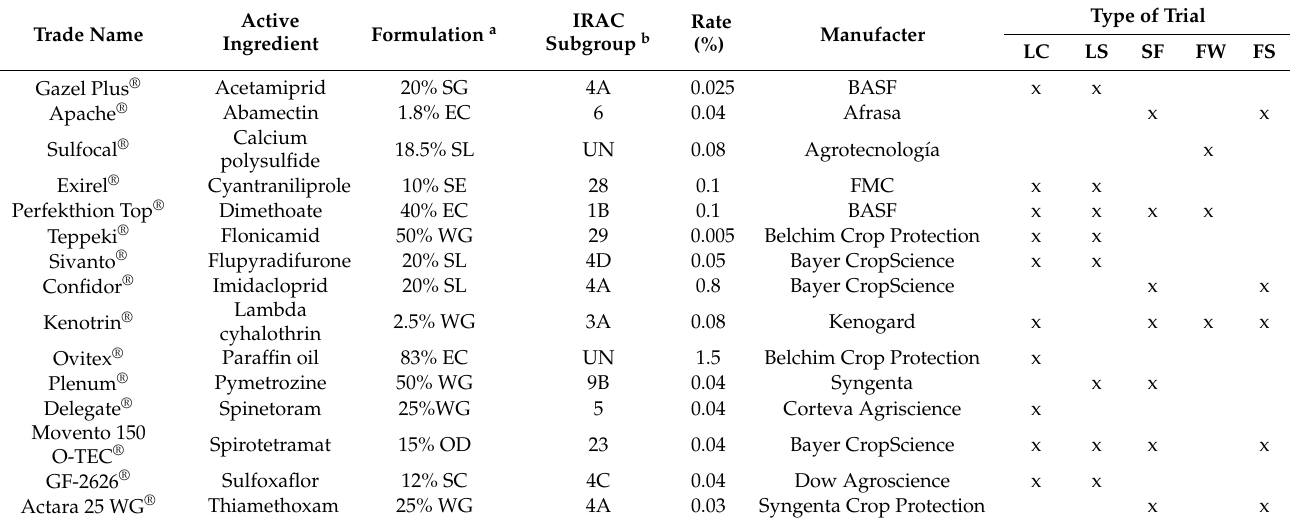
Table 1. Insecticides used in the laboratory bioassays, semi-field and field trials. LC: contact lab bioassay; LS: systemic lab bioassay; SF: semi-field trial; FW: winter field trial; FS: spring field